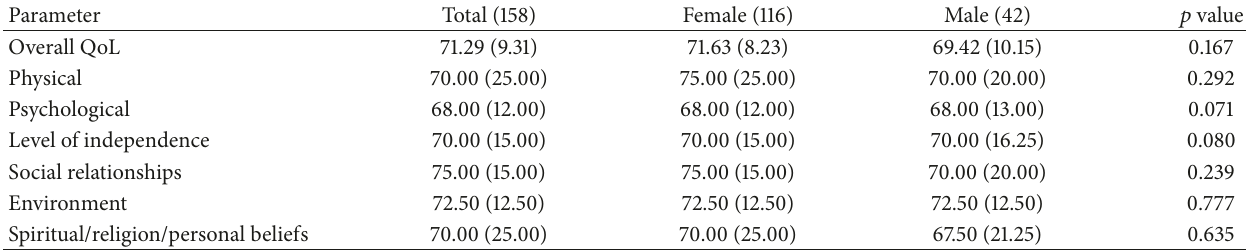
Table 2: Quality of life score and component quality of life scores stratified by gender.